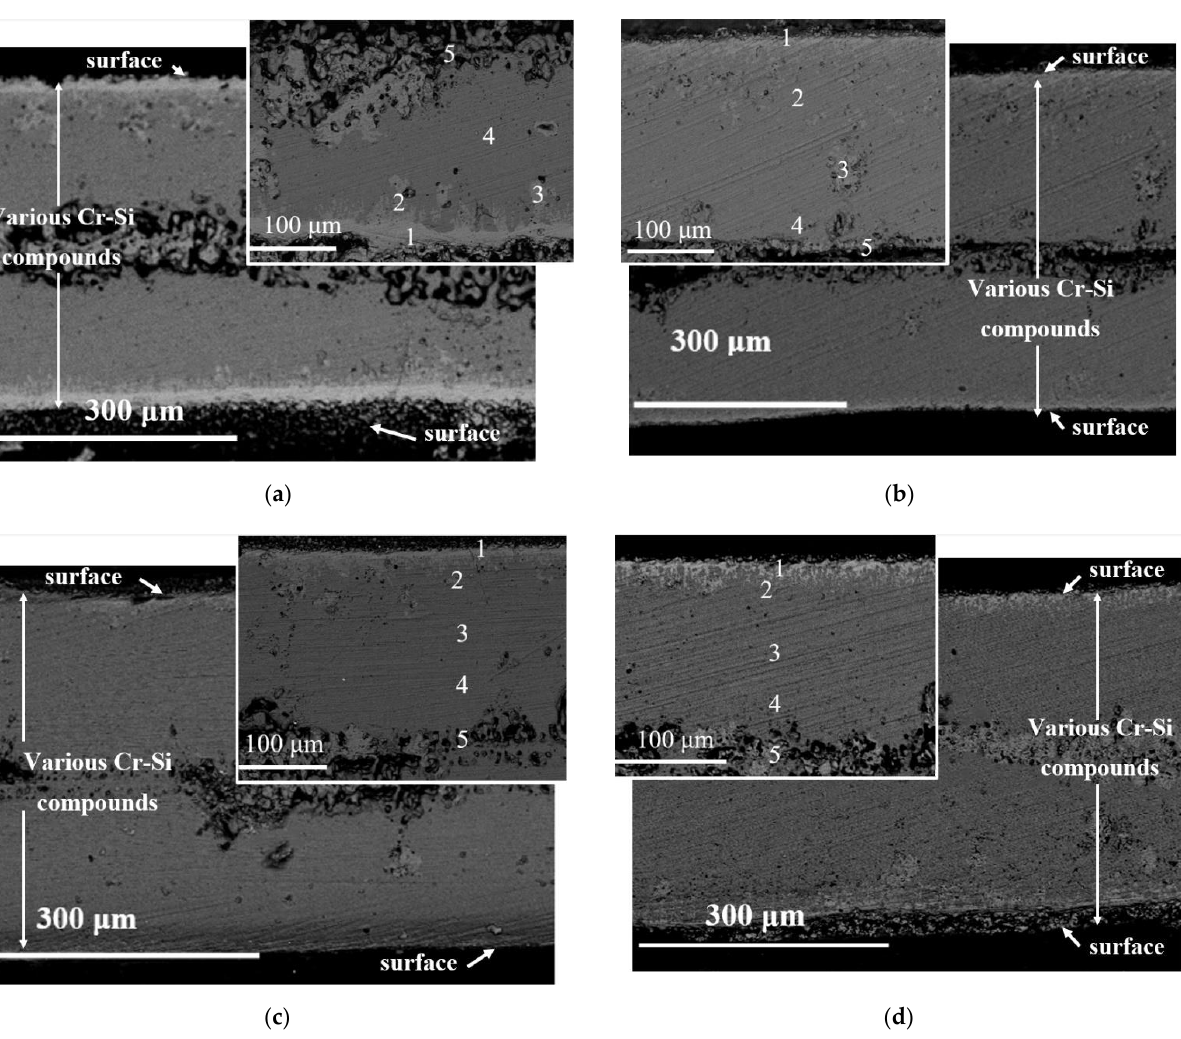
Figure 6. The cross-sectional SEM micrographs at 300 μ m and 100 μ m (shown inset) of the chromized samples, obtained by use of 40 wt.% Cr, deposited at 1000 °C for ( a ) 120 min; ( b ) 60 min; ( c ) 30 min; ( d ) 15 min. The areas denoted as #1, #2, #3, #4, and #5 correspond to the EDS analysis presented in Table 3.